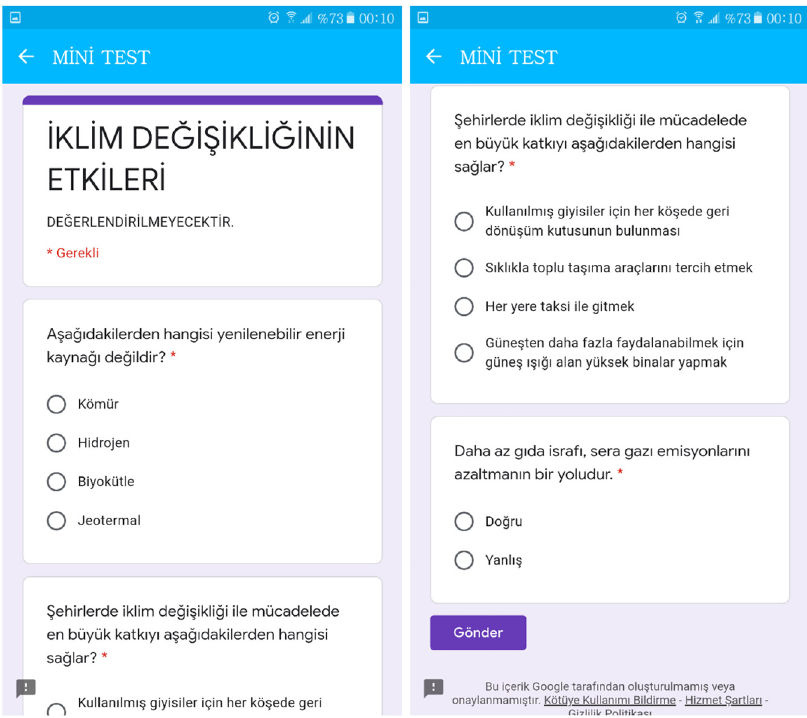
Figure 1: Mini tests used in the